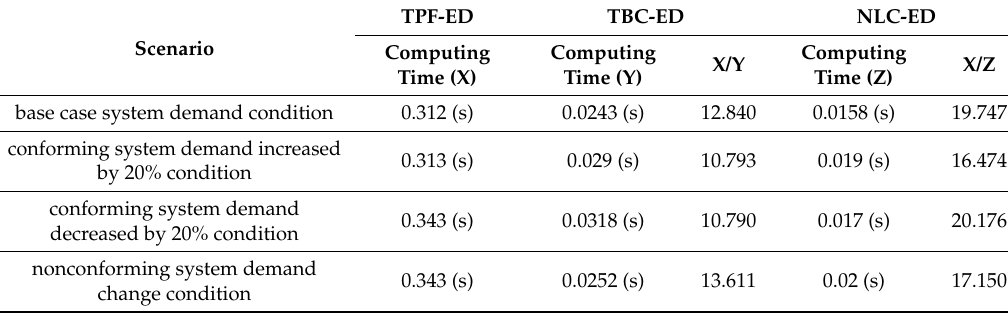
Table 14. Computing time comparison of the IEEE 30-bus